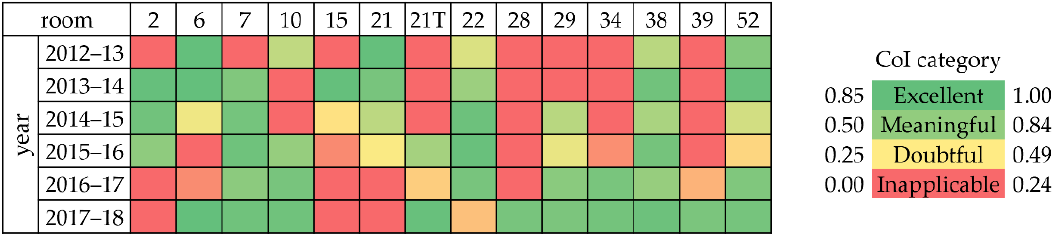
Figure 5. Results of the completeness index (CoI) for each room and each year over the period under study. Note that the term “year” here indicates the period (365 days) covering the months from June to May of the following year.